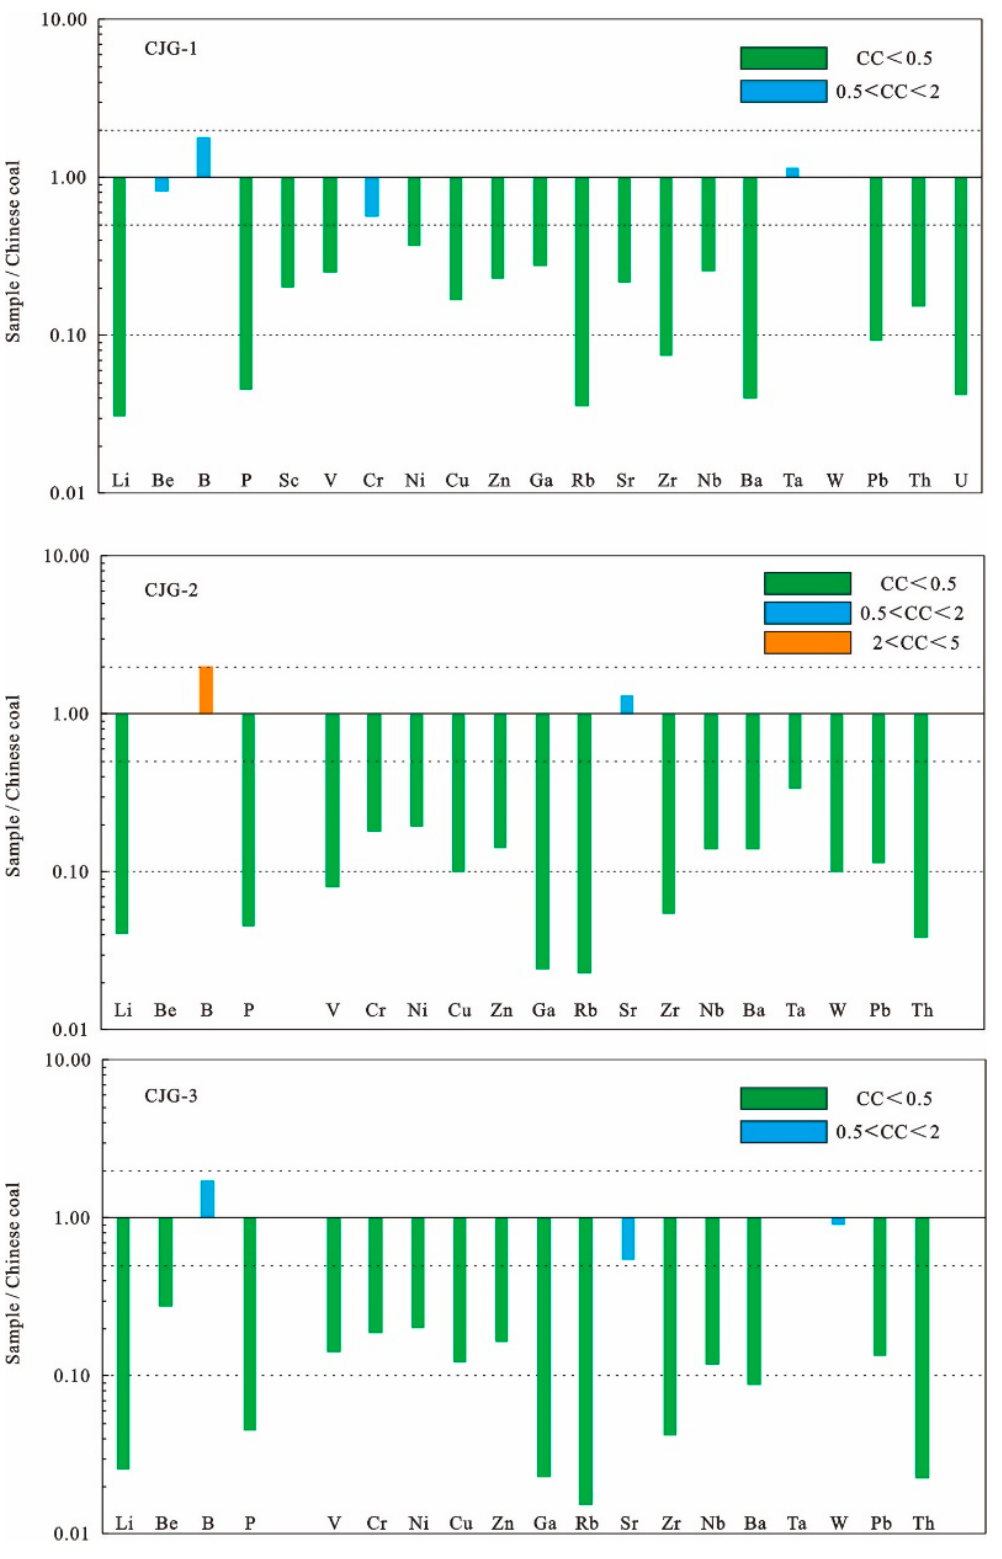
Figure 10. Concentration coefficients (CC) of trace elements of the Jurassic coals in the Cuijiagou underground coal mine compared to the averages trace elements for Chinese coals [5].